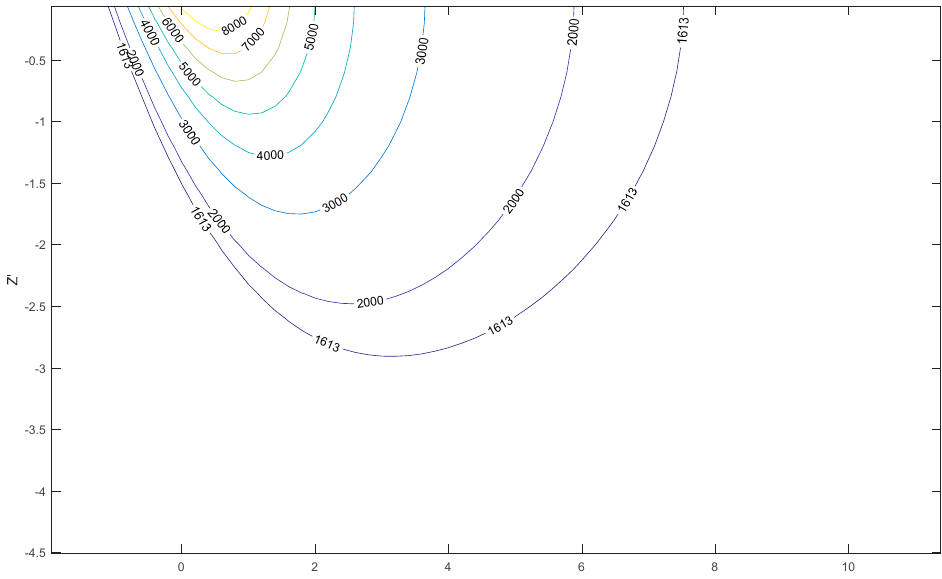
Figure A4. Melt pool temperature contour at longitudinal view for In718 with a laser power of 100 W, scanning speed of 1 mm/s, laser spot radius of 50 μ m and absorptivity at room temperature.